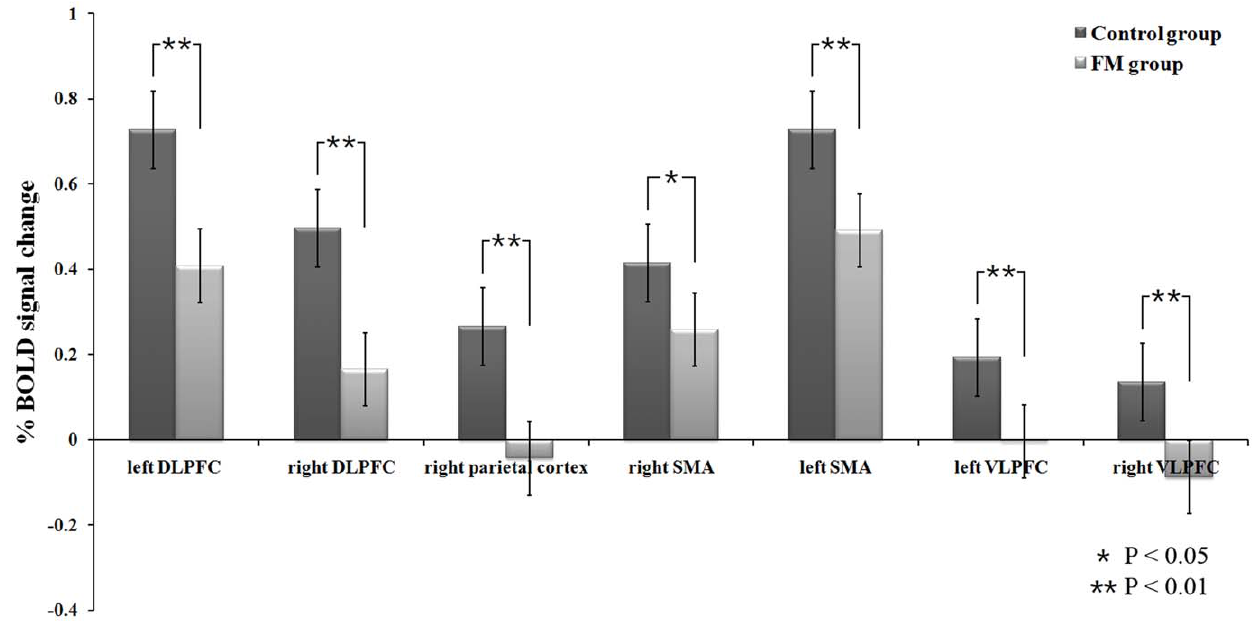
Figure 2. BOLD signal changes for 2-back task. Mean percentage changes of BOLD signal for 2-back memory task in the control group (blue) and in the fibromyalgia (FM) group (red). While both groups showed an activation of working memory network, the control group has stronger BOLD activity than that of the FM group at the activated brain regions. At the right parietal cortex and the right VLPFC, the FM patients even showed negative activity. *p , 0.05, **p , 0.01, significant difference of two groups. doi:10.1371/journal.pone.0037808.g002 PLoS ONE |